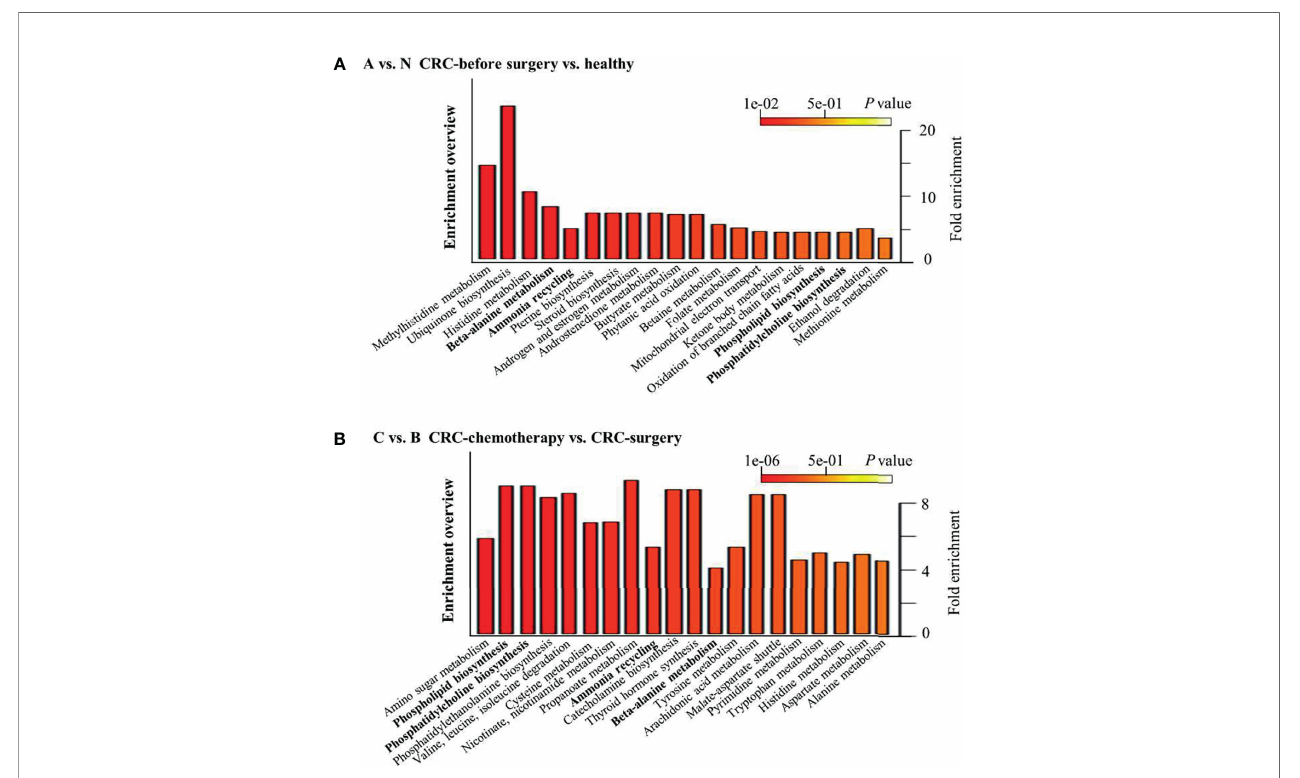
FIGURE 6 | Top 20 enriched pathways between selected clinical groups. (A) CRC patients versus healthy controls and (B) CRC patients after chemotherapy versus patients after